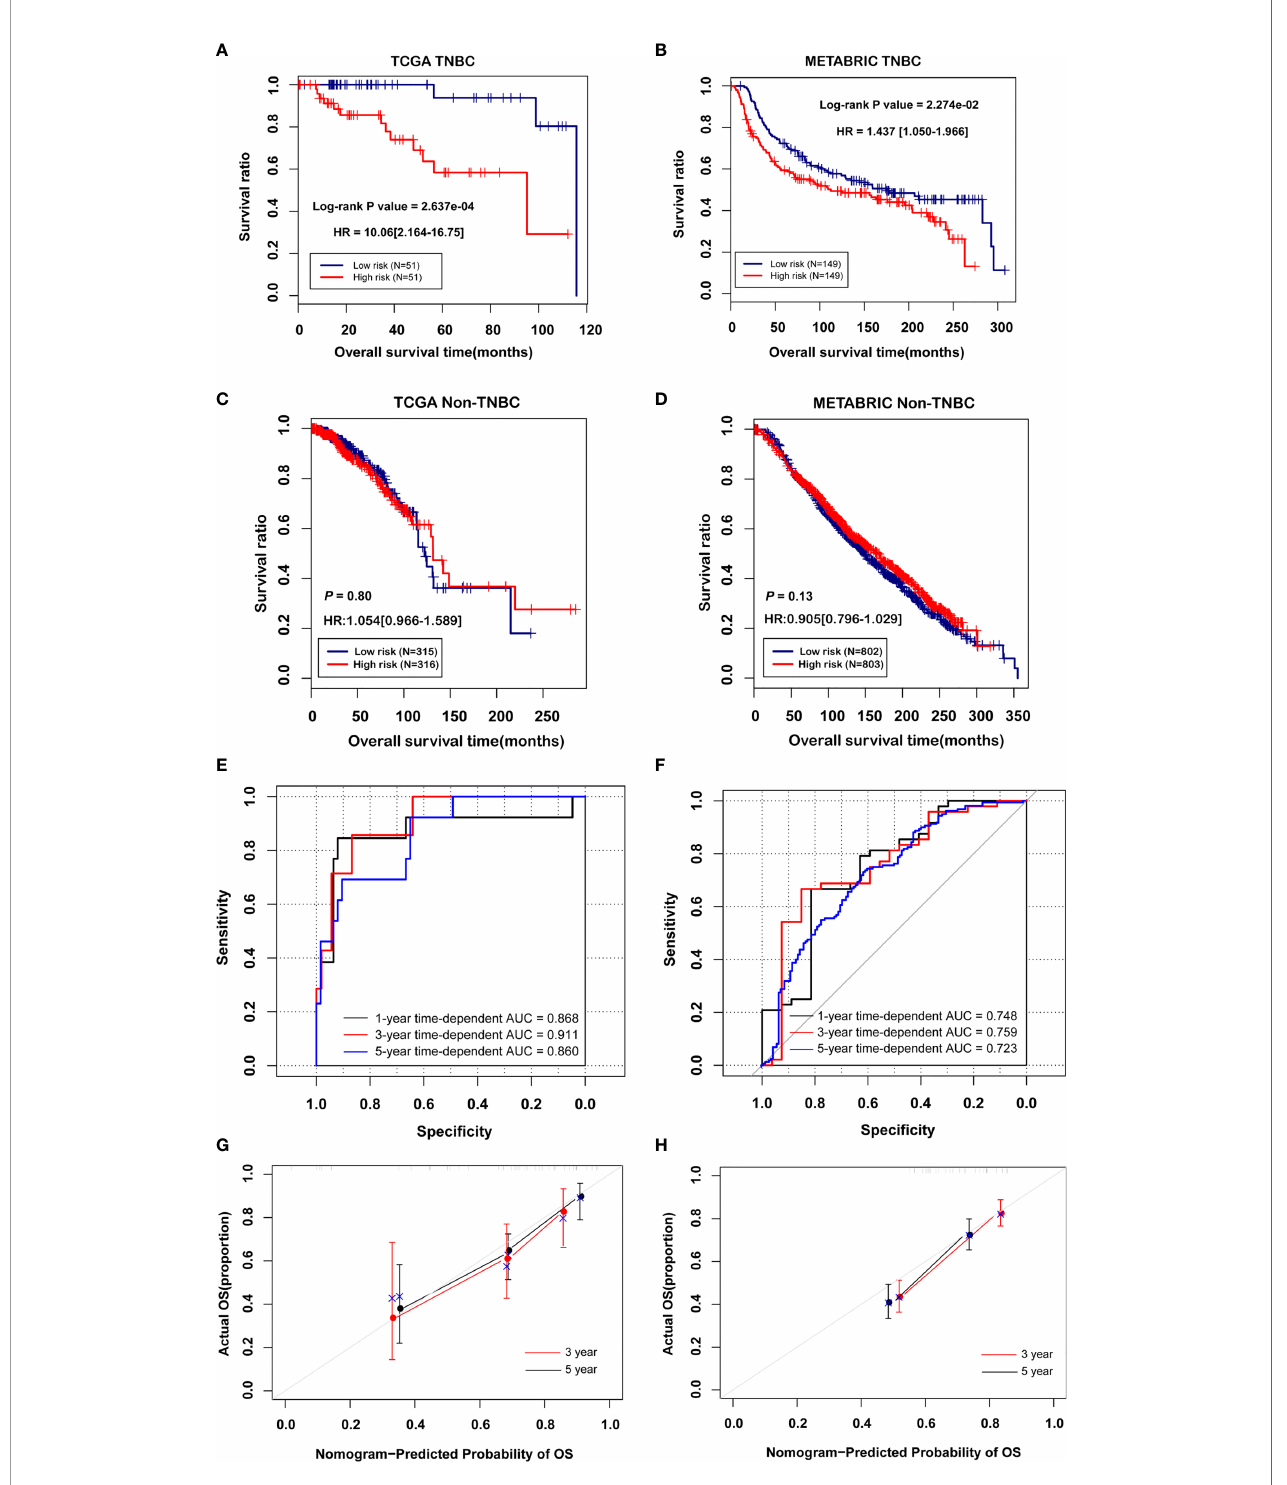
FIGURE 5 | Validation of the prognostic model. (A, B) Kaplan-Meier curve based on the PS prediction model and prognostic correlation in TNBC groups. (C, D) Kaplan- Meier curve based on the PS prediction model and prognostic correlation in non-TNBC groups. (E, F) The ROC curve of the PS forecast model, with the black, red and blue curves representing the 1-year, 3-year and 5-year curves, respectively. (G, H) Three- and 5-year calibration curves based on the PS forecast